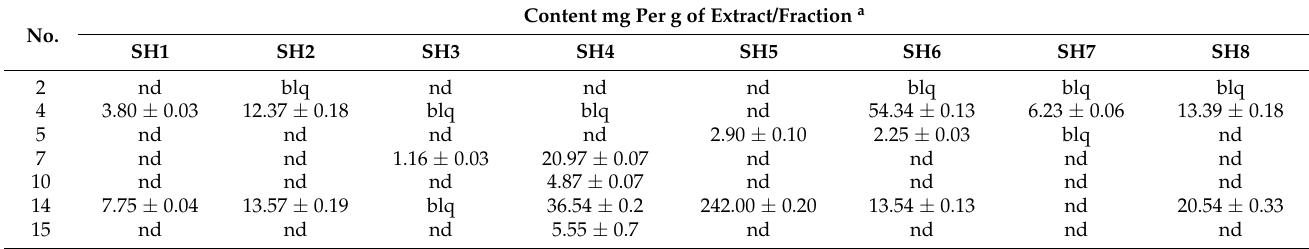
Table 3. Assessment of apigenin and caffeoylquinic derivatives content in extracts (SH1-SH3, SH8) and fractions (SH4-SH7) of S. hispanica